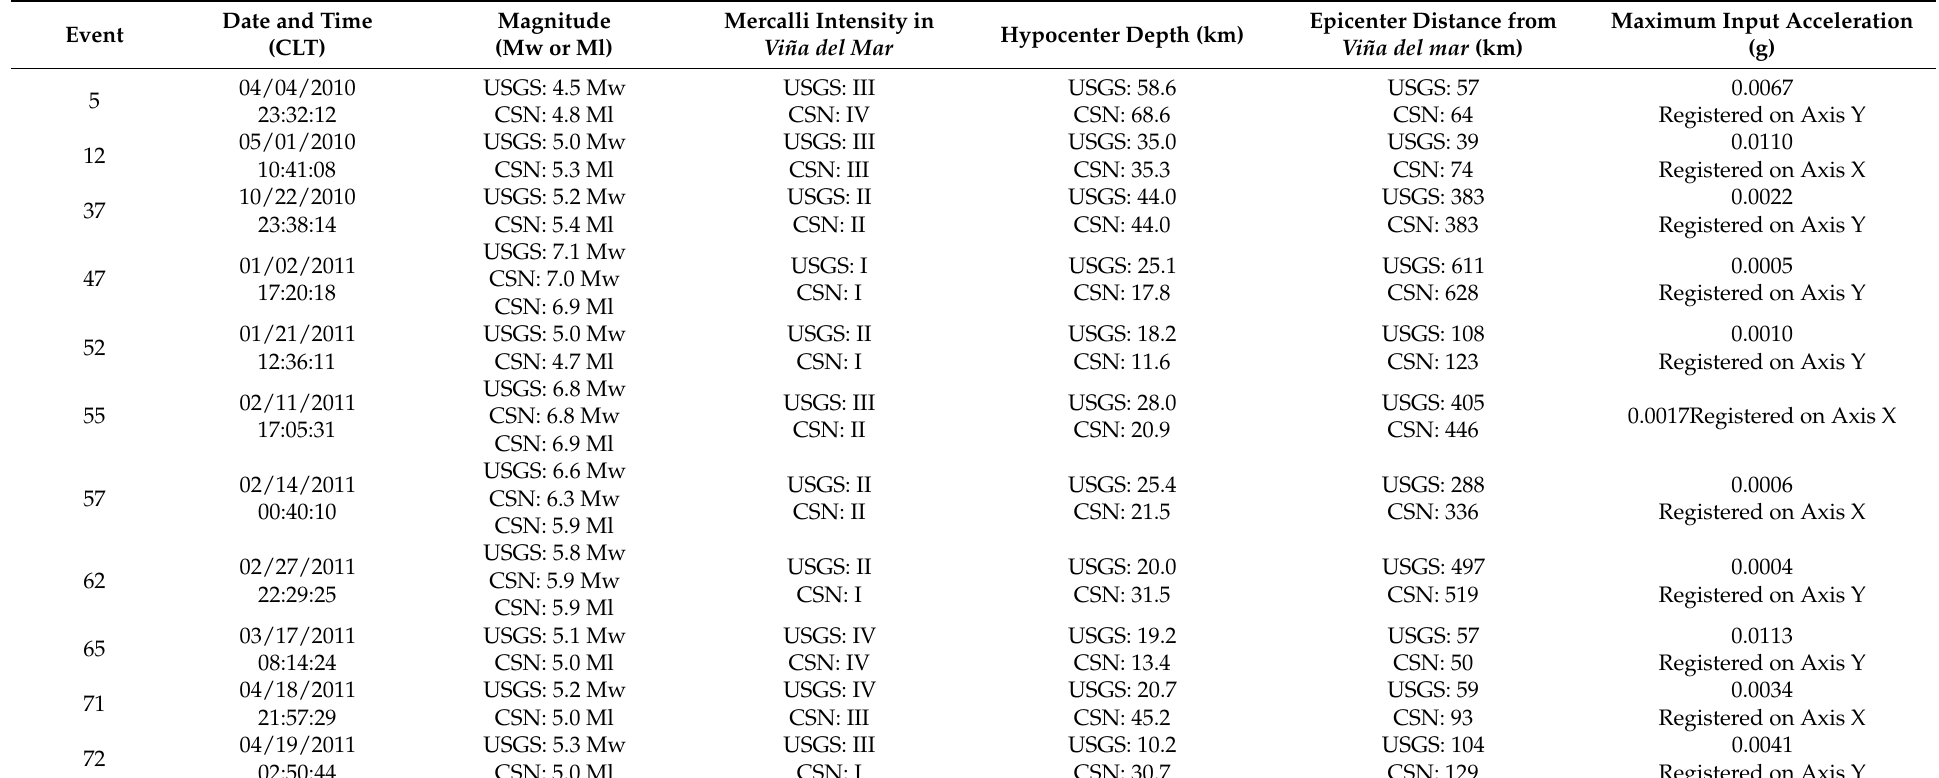
Table 3. Parameters of seismic events